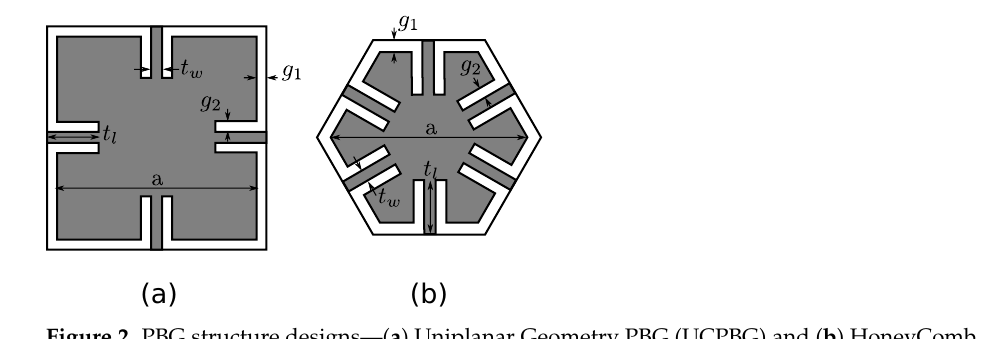
Figure 2. PBG structure designs—( a ) Uniplanar Geometry PBG (UCPBG) and ( b ) HoneyComb PBG